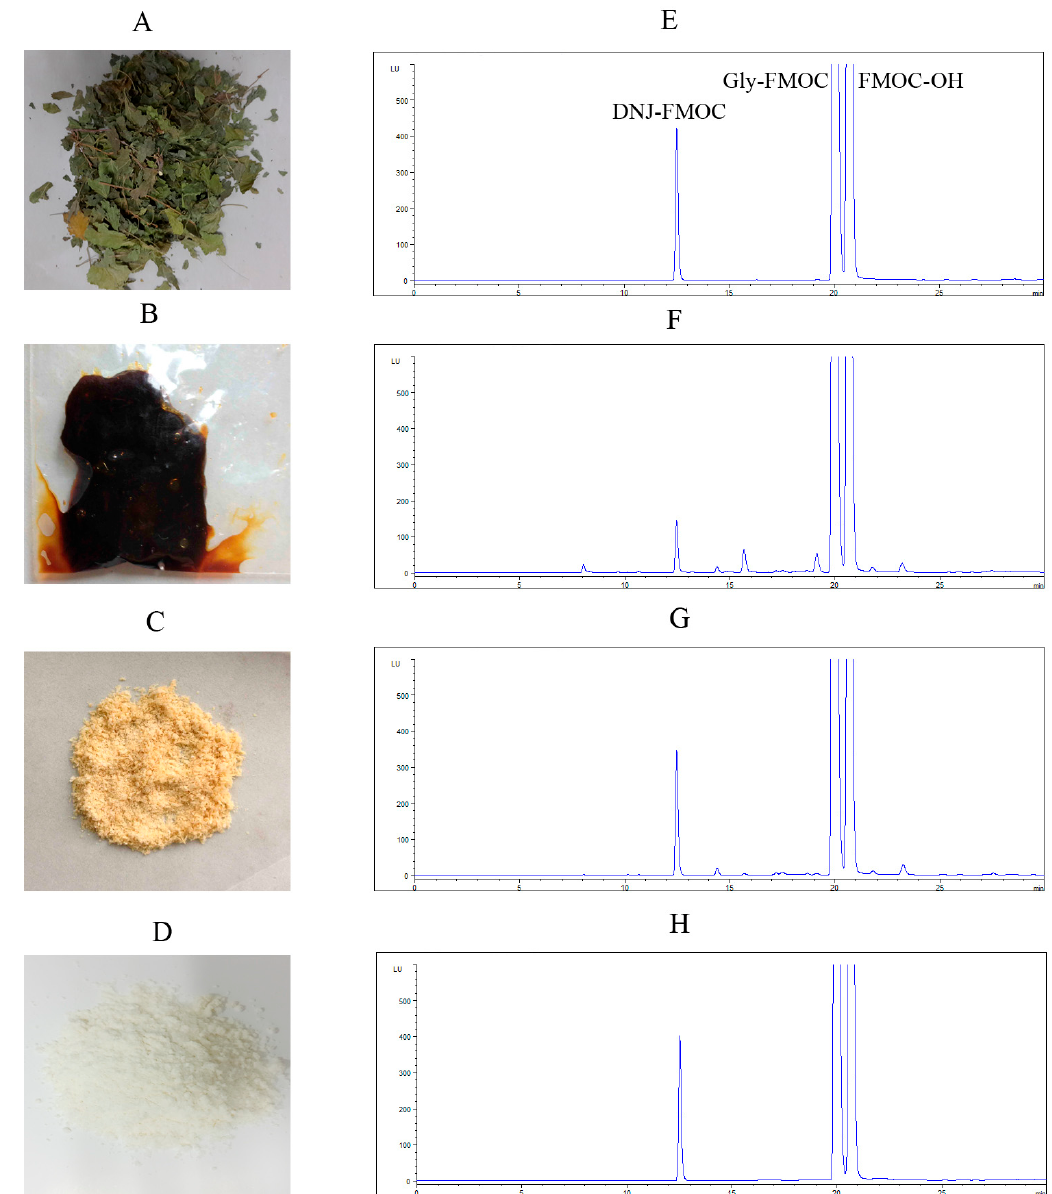
Figure 2. Preparation of DNJ: Dried mulberry leaves ( A ) was extracted by boiled water, purified by citation exchange resin and anion exchange resin ( B ); purified by silica gel H ( C ); and crystallized in 95% ethanol ( D ) successively; ( E – H ) Chromatograms of DNJ standard ( E ); sample purified by ion exchange resin ( F ); silica gel H ( G ); and the final product ( H ). DNJ was made to react with fluorenylmethoxycarbonyl chloride (FMOC-Cl) to generate the DNJ–FMOC derivative and detected by High Performance Liquid Chromatography coupled with fluorescence detector (HPLC-FLD).